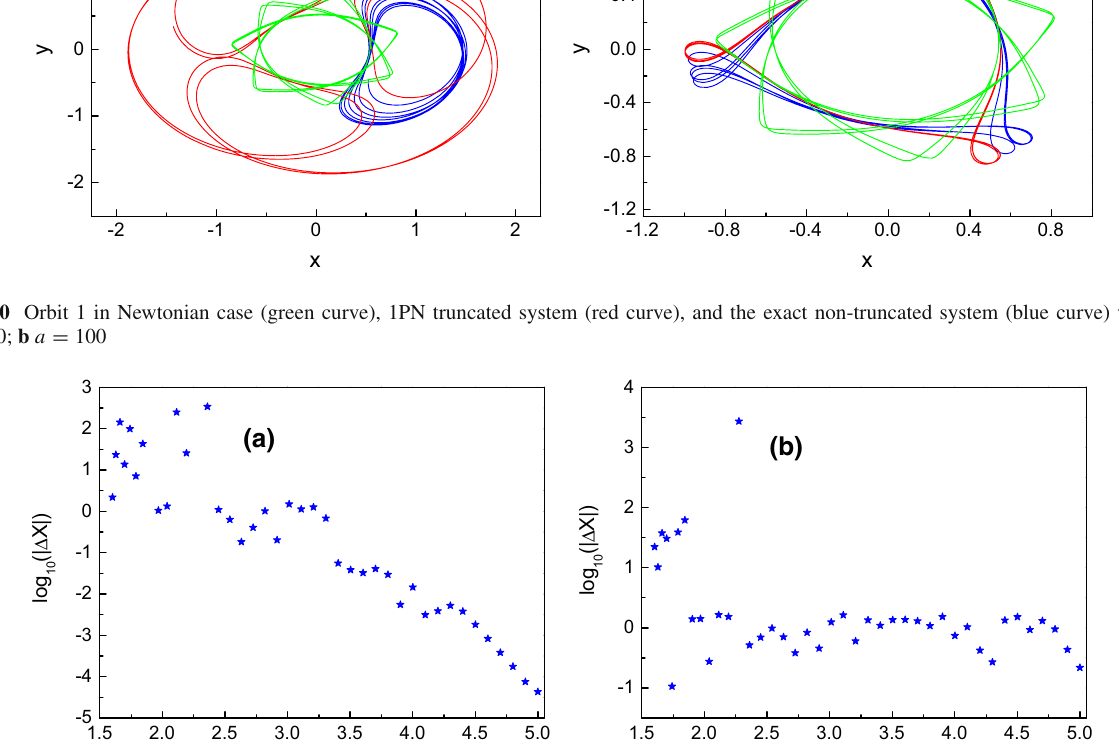
Fig. 12 Dependence of the maximum values of R = for Orbit 1 in the two systems